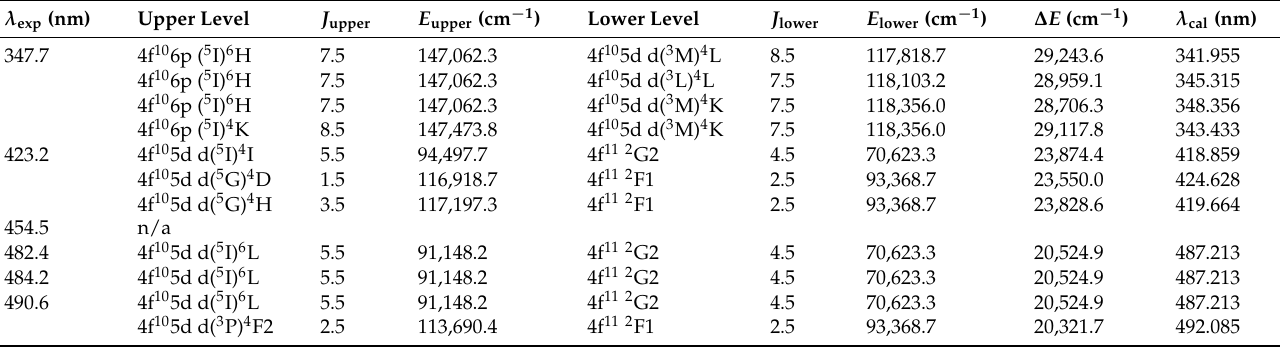
Table 1. Observed transition wavelengths of Er 3 + and possible upper and lower levels of the transi- tions. λ exp means the vacuum wavelengths measured in the experiments. J , E , ∆ E , and λ cal mean the total angular momentum, the energy value, the difference between the energy of the upper level and the lower levels, and the calculated wavelength using the energy difference ∆ E ,